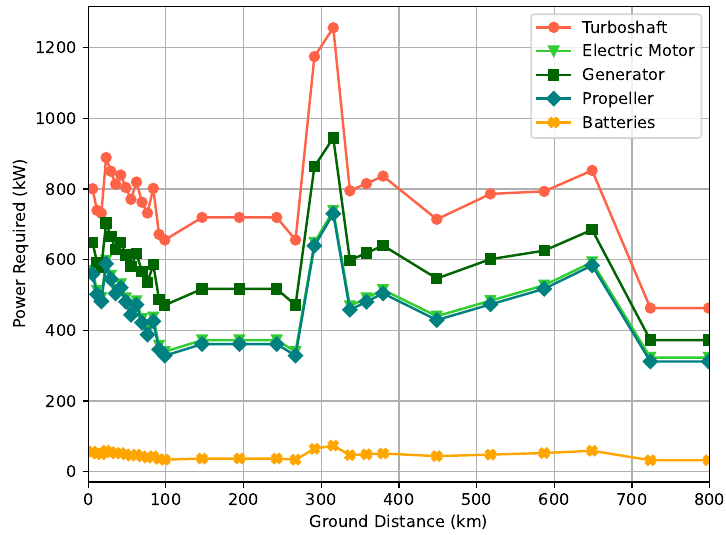
Figure 10. Power required to the series hybrid propulsive system.